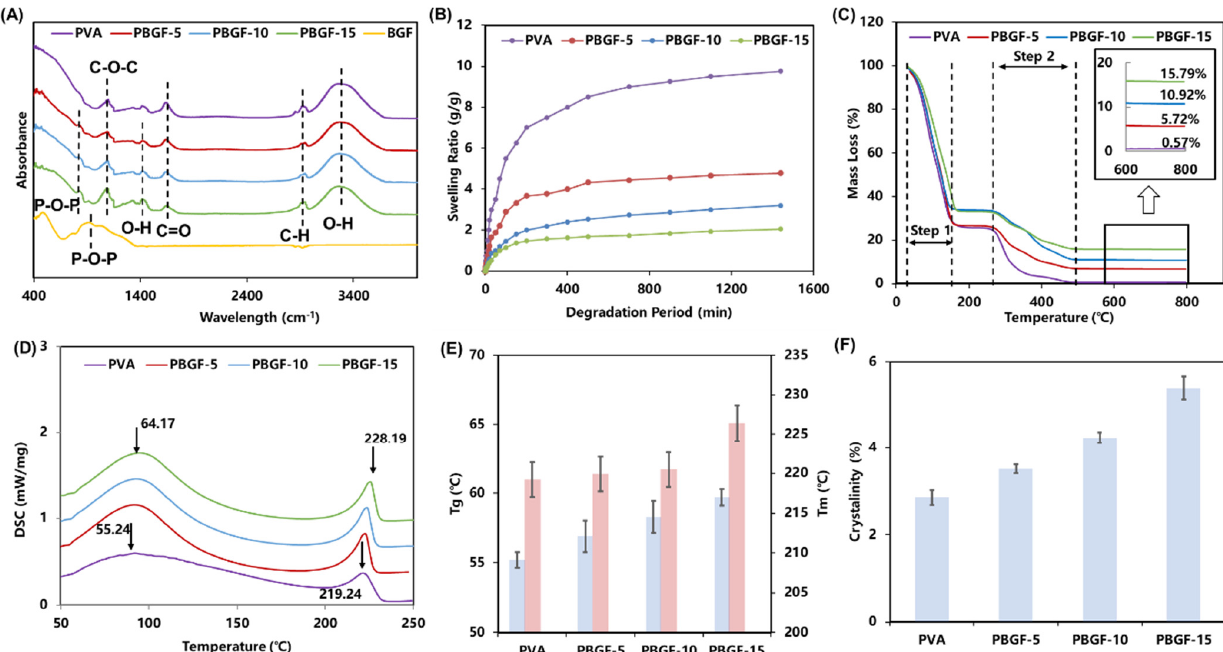
Figure 1. ( A ) ATR-IR spectra of BGF, PVA, and PBGF composites; ( B ) swelling kinetics; ( C ) TGA curve; ( D ) DSC curve; ( E ) glass transition temperature (T g ) and melting point (T m ); ( F ) crystallinity percentage for PVA and PBGF composites. Table 1. The FTIR functional groups and corresponding